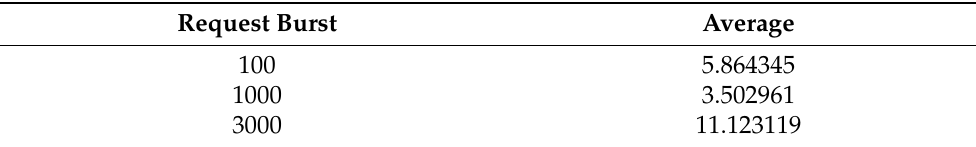
Table 3. Average response time (in ms) in front of different request